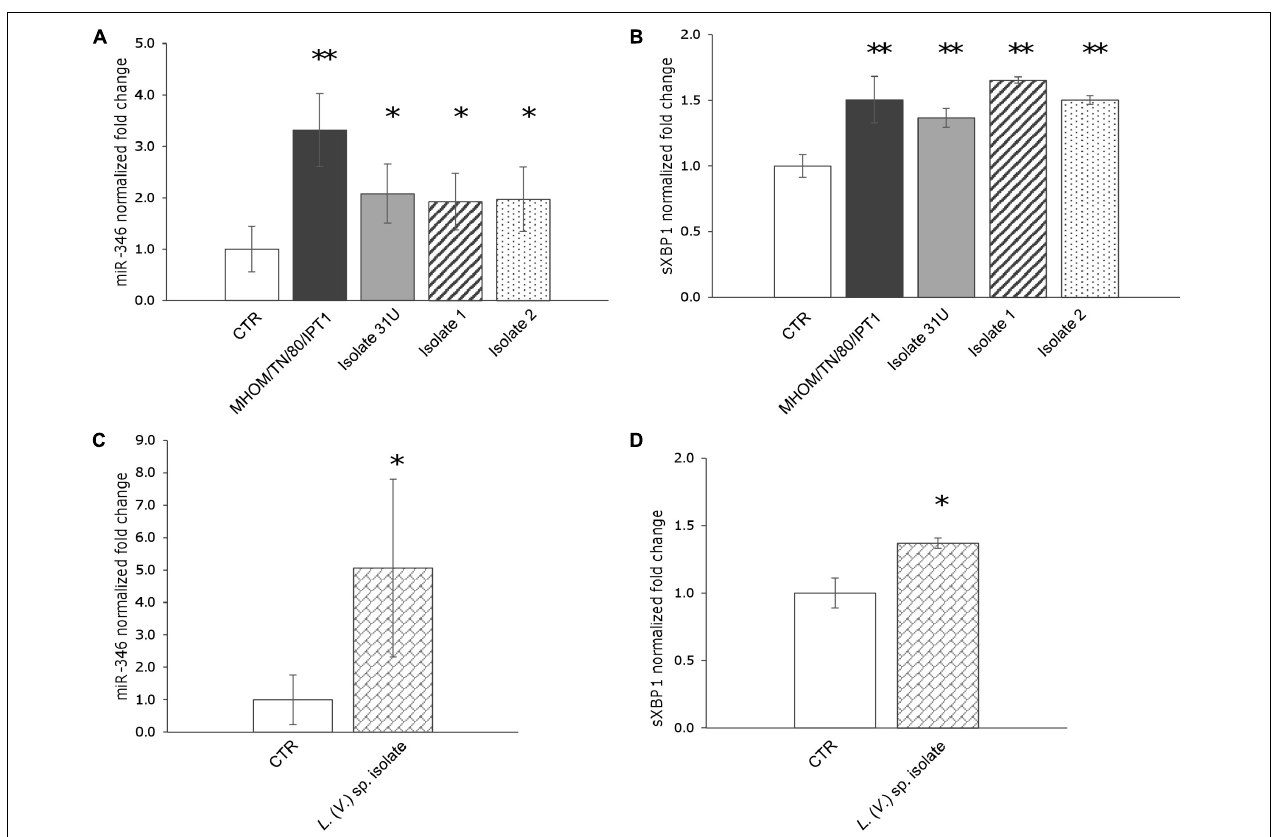
FIGURE 3 | miR-346 is upregulated in THP-1-derived macrophages infected with L. ( L. ) infantum and L. ( V. ) sp. (A) miR-346 expression in cells infected for 24 h with L. ( L. ) infantum MHOM/TN/80/IPT1 strain (dark gray bars) or clinical isolate 31U (light gray bars), isolate 1 (dashed bars), isolate 2 (dotted bars). (B) sXBP1 expression in the same cells used to monitor miR-346 expression. (C) miR-346 expression in cells infected for 24 h with L. ( V. ) sp. isolate (bricked bars). (D) sXBP1 expression in infected cells (bricked bars) compared to control cells (white bars). Data are represented as the mean ± SD of two experiments ( n = 4). CTR: non-infected cells. ∗ p < 0.05; ∗∗ p <